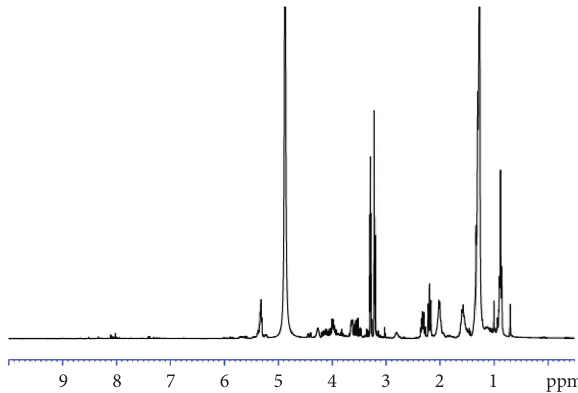
Figure 3: 1 H NMR spectrum of 75% v / v ethanol extract (EE) was recorded with a Bruker AVANCE 400 NMR spectrometer at